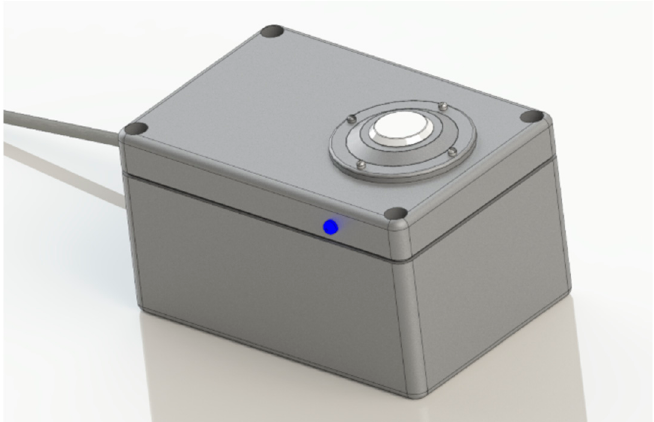
Figure 1. Concept developed in a virtual environment for the wireless solar irradiation monitoring system at the surface.